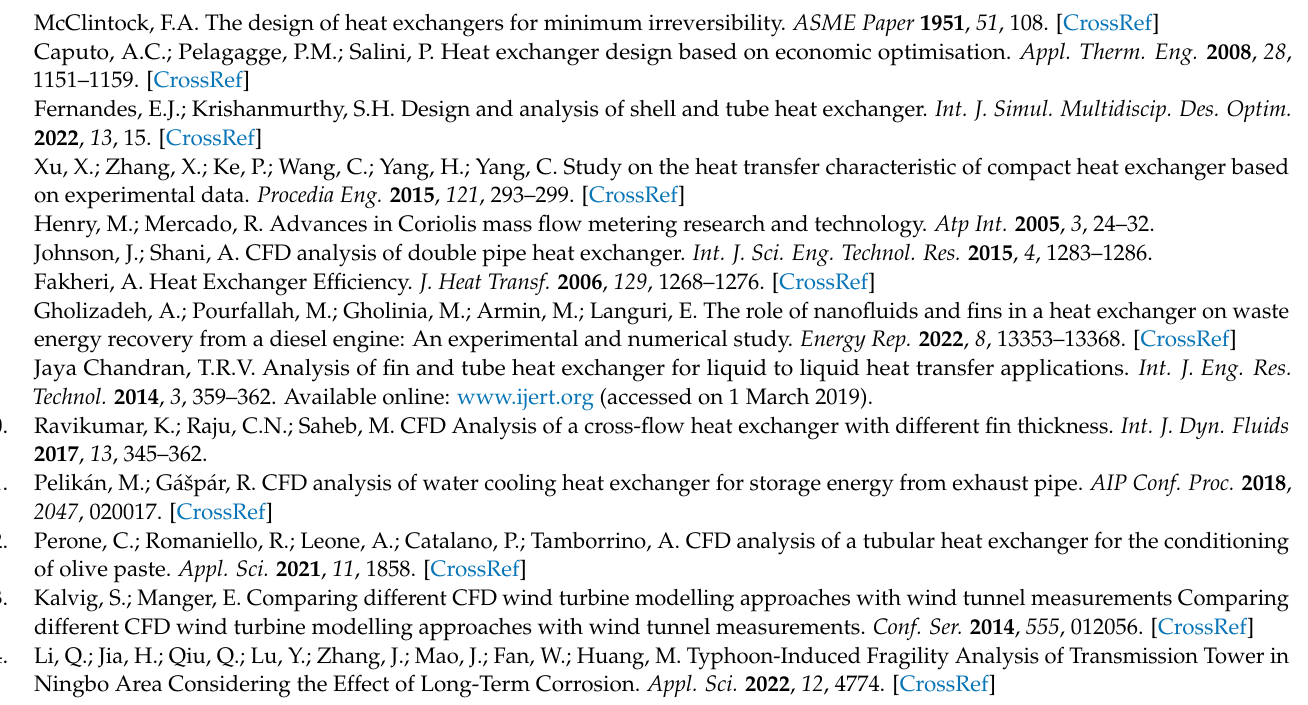
Figure S2: Projected Surface area; Figure S3: Cross section meshes; Figures S4 and S5: multiple experimental components; Figure S6: Assembling operations of the tubes; Table S1: Experimental apparatus details; Videos S1–S3: Various manufacturing